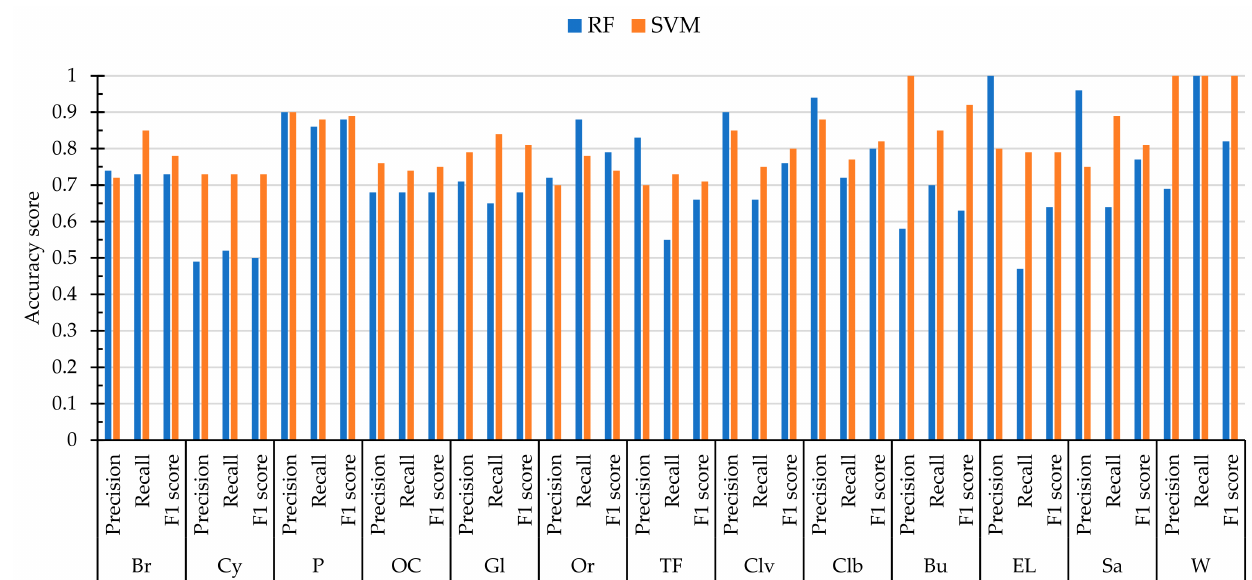
Figure 8. A paired-bar chart for comparison of precision, recall, and F1-score in every class at Level-III LULC classification obtained by RF and SVM. As noted, the two classifiers appeared equal efficiency in pine, while SVM achieved reliable classification in cypress (Cy), other conifer (OC), grassland (Gl), and built-up (Bu) as it obtained all the accuracy measures substantially greater than RF. The strength of RF was its ability torecognize orchard more efficiently than SVM. In general, the capability of RF in classifying LULC is generally poorer than SVM based on F1-score of all